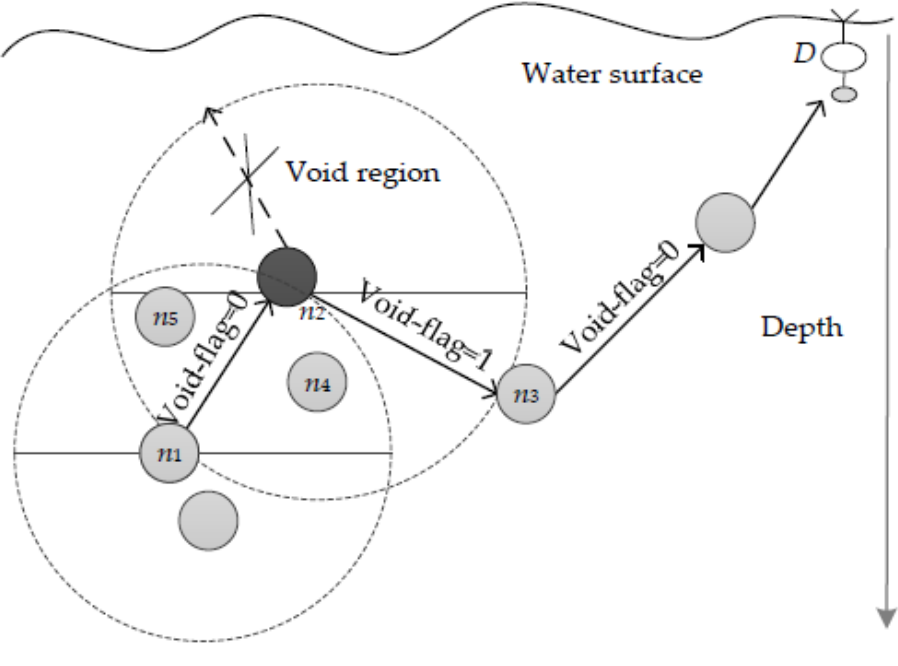
Figure 16. EDORQ void recovery mode [55].